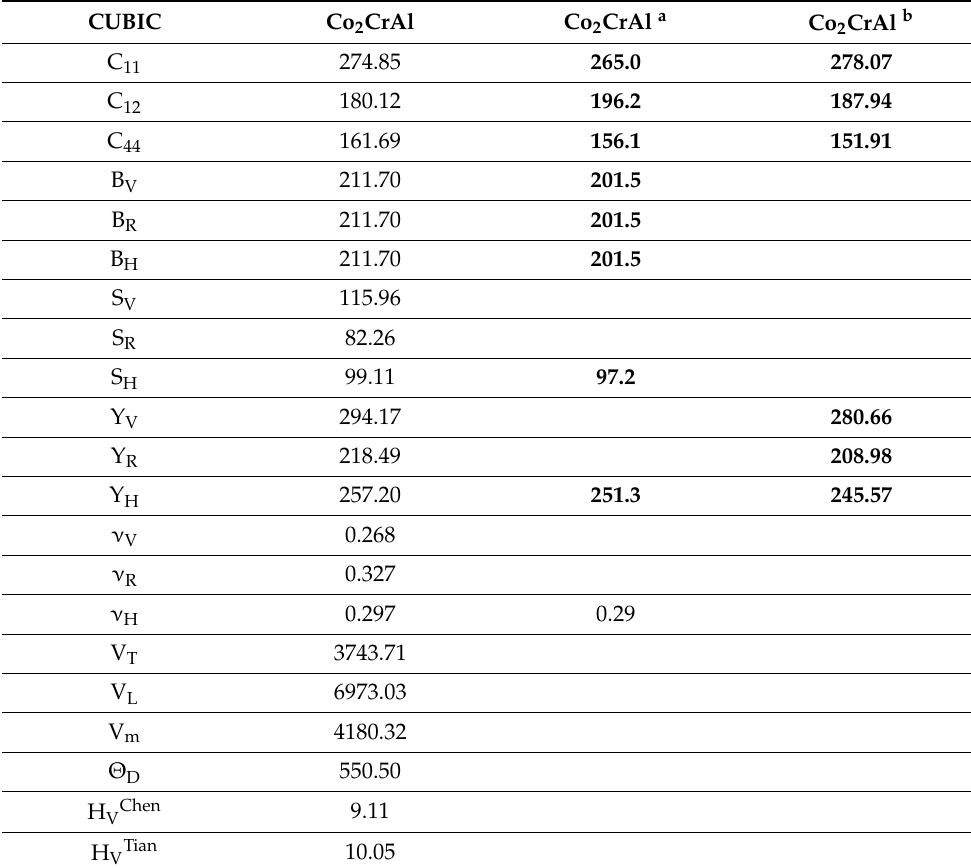
Table 2. The values of elastic constants (C ij in (GPa)), Bulk moduli (B), shear moduli (S), and Young’s moduli (Y) in GPa in the Voigt-Reuss-Hill (VRH) approximation, Poisson’s ratios ( ν ), as well as transverse (V t ), longitudinal (V L ) and average wave velocities (V m in m/s), Debye temperature ( Θ D in (K)) and Vickers hardness base on the Chen and Tian equations (H V in (GPa)) for the bulk form of Co 2 CrAl. CUBIC Co 2 CrAl Co 2 CrAl a Co 2 CrAl b C 11 274.85 265.0 278.07 180.12 196.2 187.94 161.69 156.1 151.91 211.70 201.5